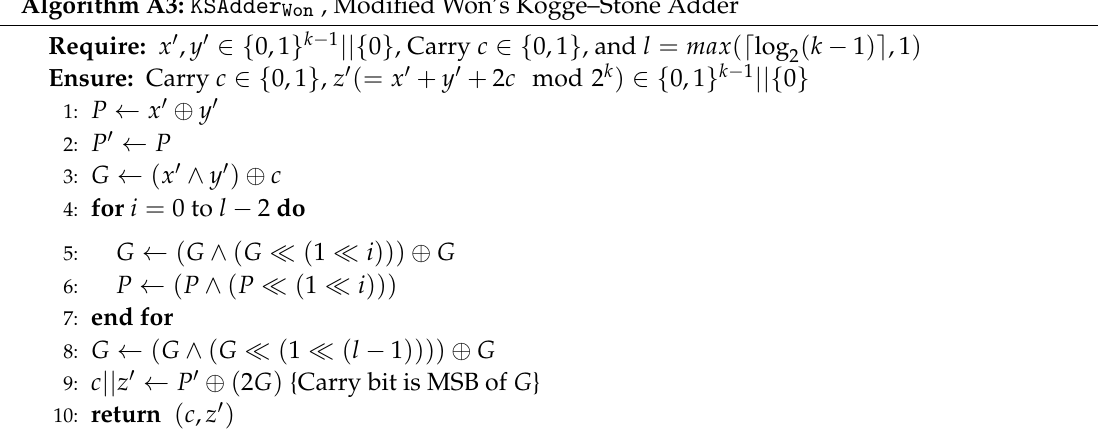
Algorithm A3: KSAdder Won , Modified Won’s Kogge–Stone